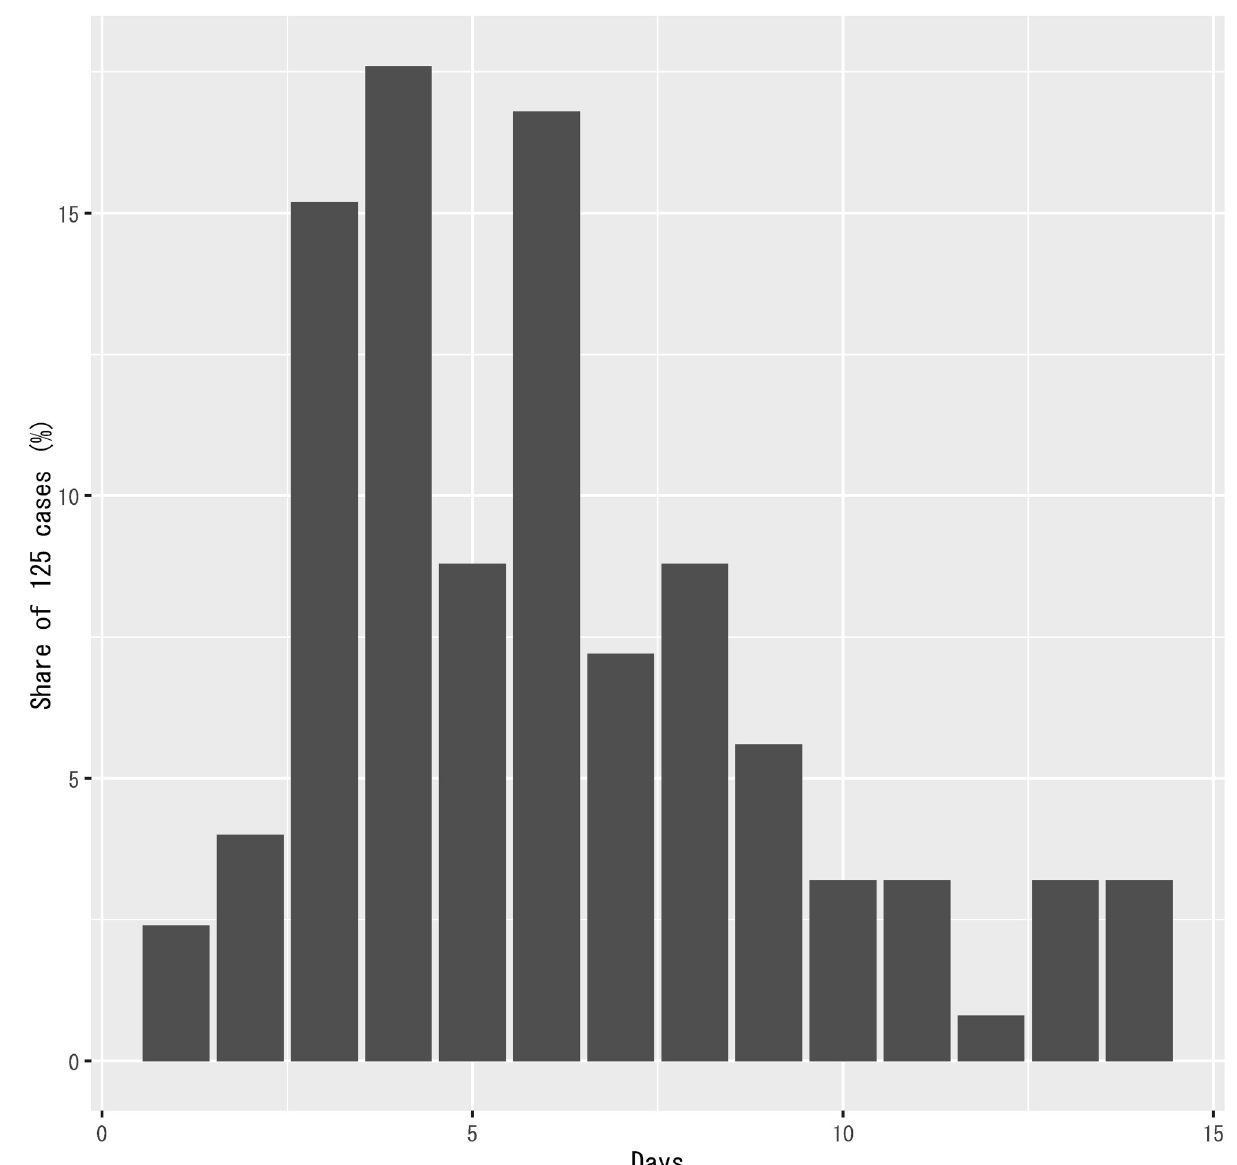
Fig 5. Sample distribution of incubation periods in Japan reported by